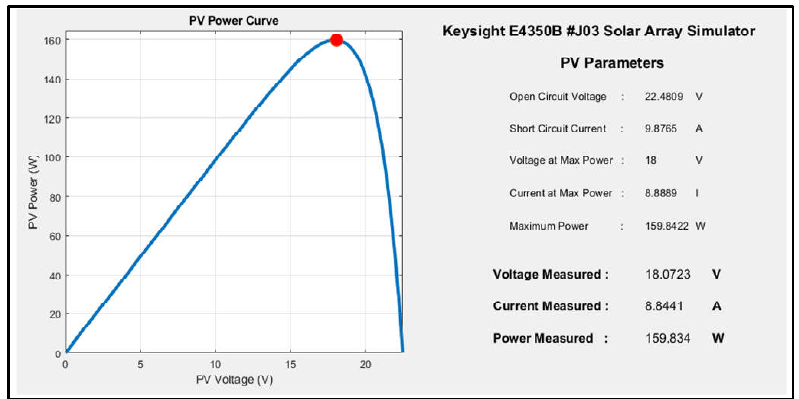
Figure 15. PV parameters at full power (Keysight E4350B Solar Array Simulator).